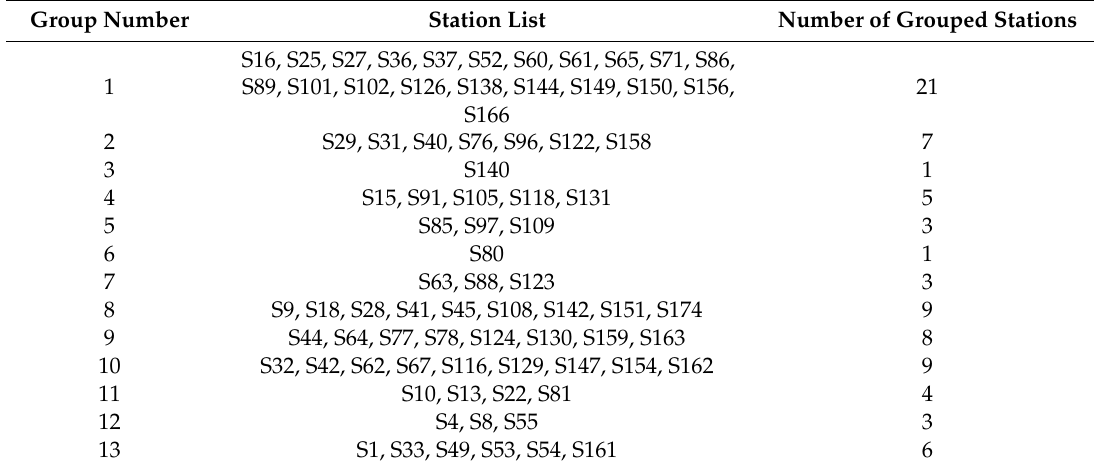
Table 5. Distribution stations by